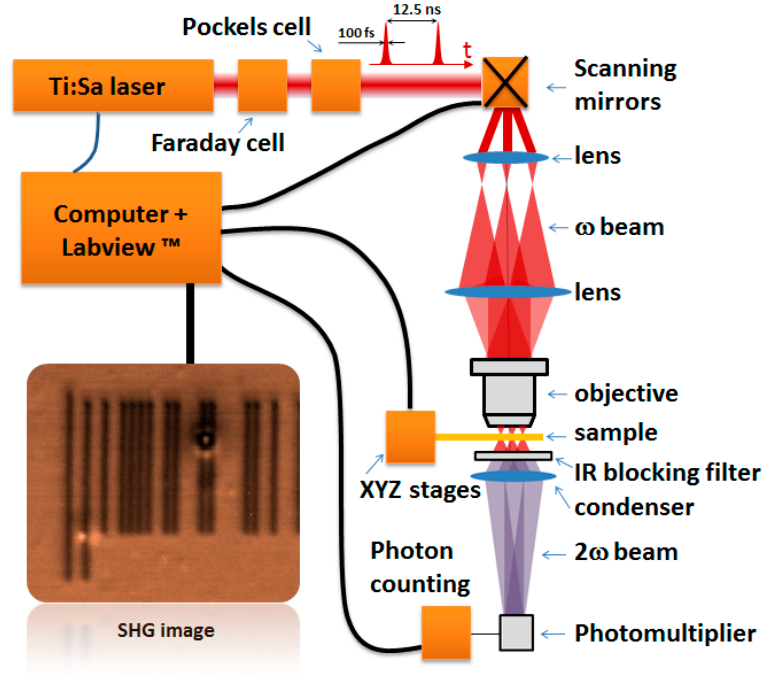
Figure 4. Non-linear scanning microscopy setup used to induce localized photo-dimerization and to detect the SHG response.